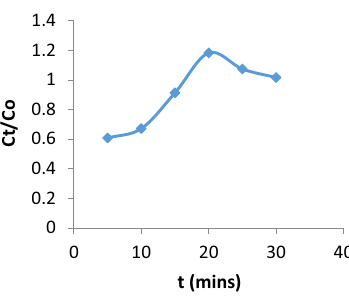
Fig. 3 Breakthrough curve at 20 mg/L